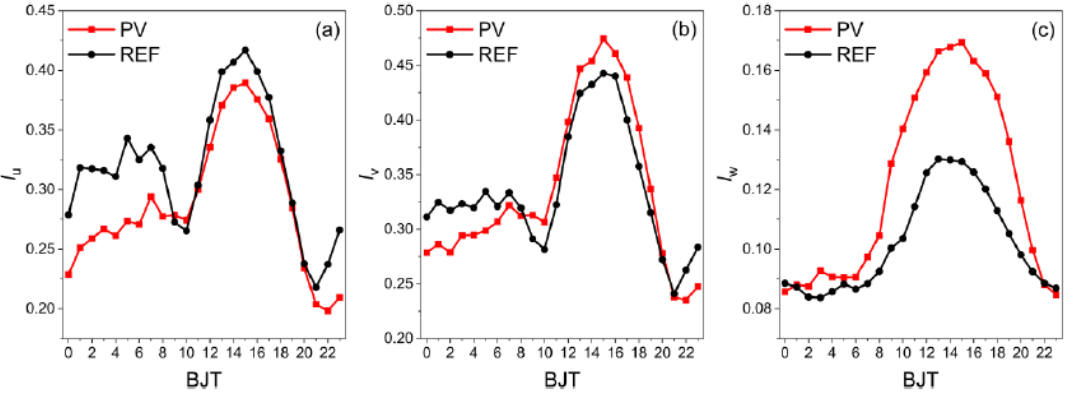
Figure 4. The average daily variation of turbulence strength component of longitudinal wind I u ( a ), lateral wind I v ( b ), and vertical wind I w ( c ) in the PV plant (red line) and the reference site (black line), BJT is to Beijing time